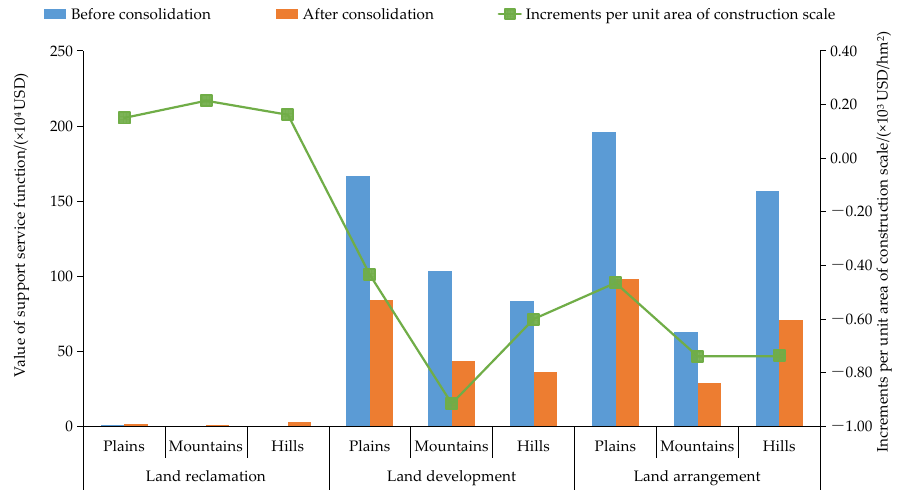
Figure 5. Change in value of support service function before and after consolidation in typical land consolidation project areas in Hubei province.